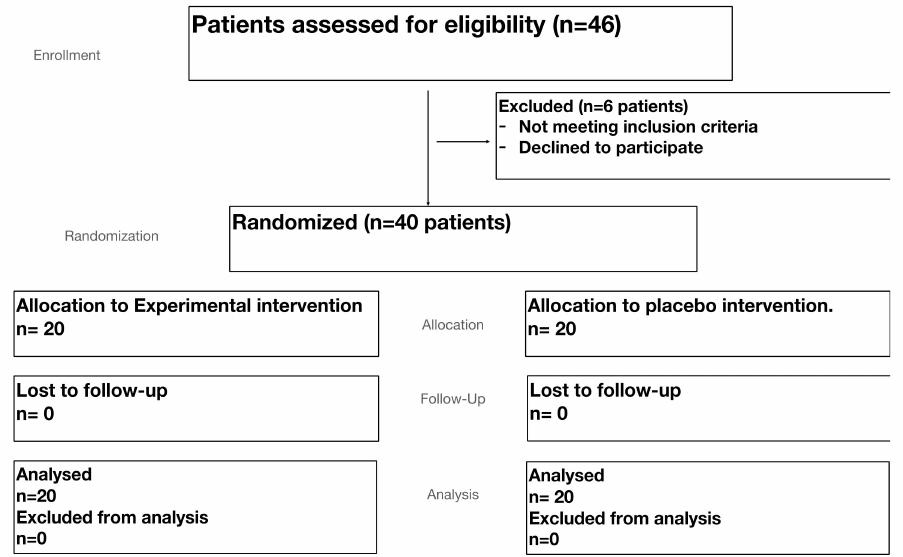
Figure 1. Flowchart diagram showing the process of the study.